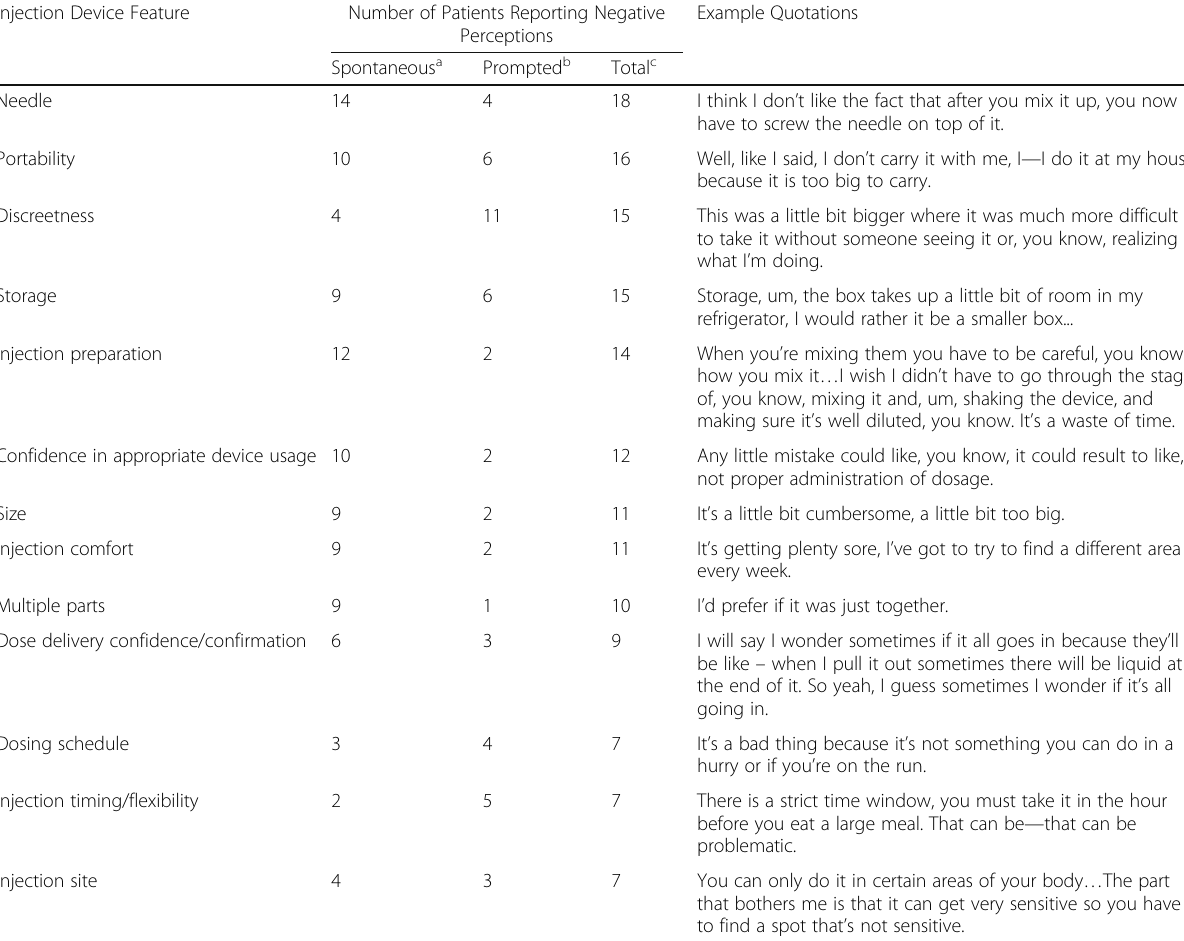
Table 3 Negative Perceptions of Injection Device Attributes ( N = 32) Injection Device